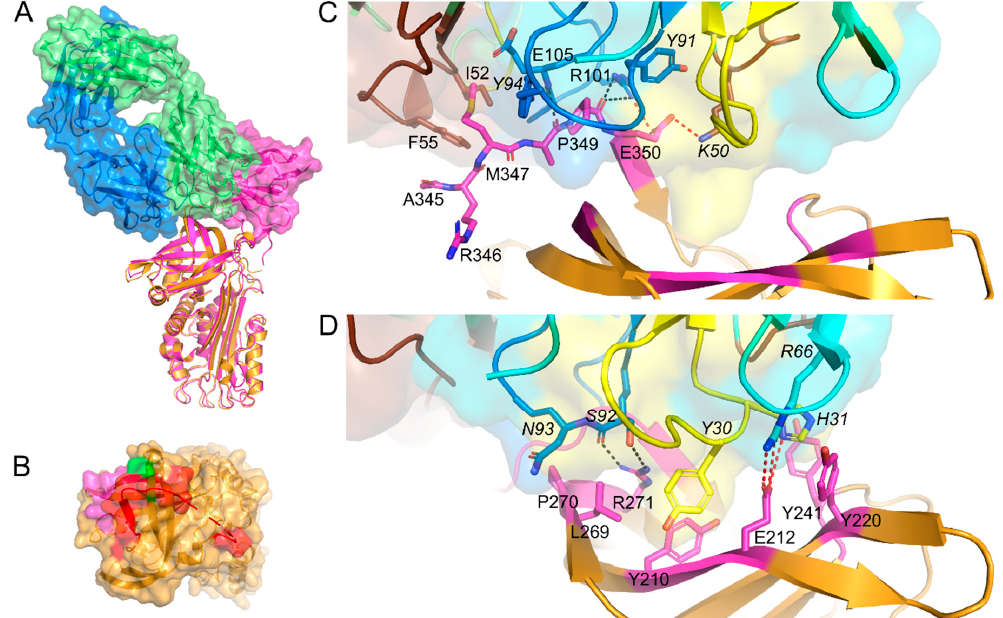
Figure 3. Crystal structures of the PAI-1/Nb93 complex and the PAI-1/Fab-MEDI-579 complex. ( A ) Superimposition of the structures of the PAI-1/Nb93 (magenta) complex and PAI-1/Fab-MEDI-579 complex (PDB ID 6I8S) [19]. In the latter complex PAI-1 is orange; the heavy and the light chain of the Fab fragment are colored green and blue, respectively. Together with the cartoon representation, the biological surfaces of Nb93 and the Fab fragment are represented; ( B ) Surface representation of the top of the PAI-1 molecule with the indicated contact regions (residues closer than 4 Å) for MEDI-579. MEDI-579 binds to the C-terminal part of the RCL in red and has adjacent contact regions in magenta (Tyr210, Glu212, Tyr220, and Tyr241) and green (Leu269, Pro270, and Arg271); ( C ) Detail of the interaction between MEDI-579 and the RCL of PAI-1; ( D ) Detail of the interaction between MEDI-579 and residues located in the direct environment of the RCL of PAI-1. PAI-1 is colored orange, with residues closer than 4 Å to MEDI-579 in magenta. Framework regions of MEDI-579 are in green and cyan for the heavy and light chain of the Fab fragment, respectively; CDR1, CDR2, and CDR3 of the variable heavy (V H ) and variable light (V L ) domain are colored yellow, brown, and blue, respectively. Residues located in the V L domain are cursive. Hydrogen bonds and salt bridges are indicated by black and red dotted lines, respectively.